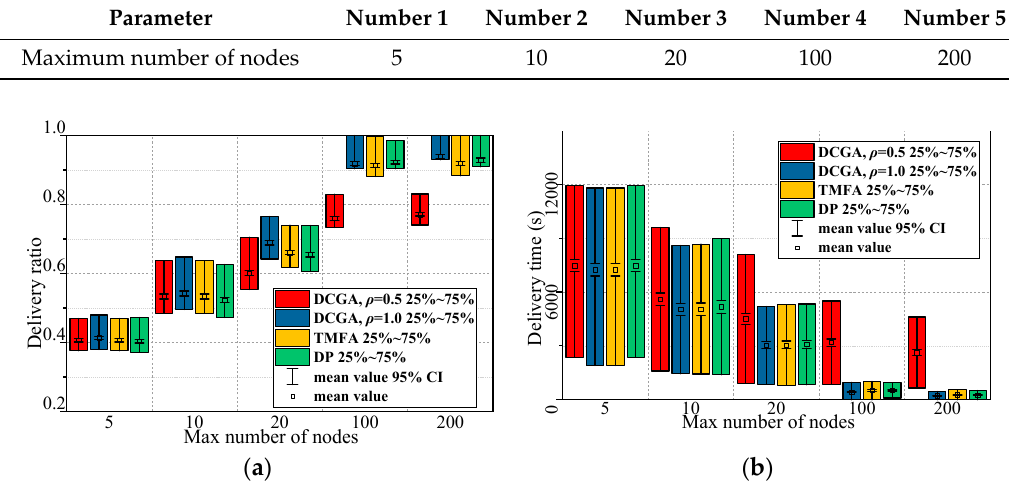
Figure 14. Results of Scenario 3. ( a ) Delivery ratio with different maximum number of nodes; ( b ) delivery time in seconds with different maximum number of nodes. Sensors 2018 , 18 , x FOR PEER REVIEW